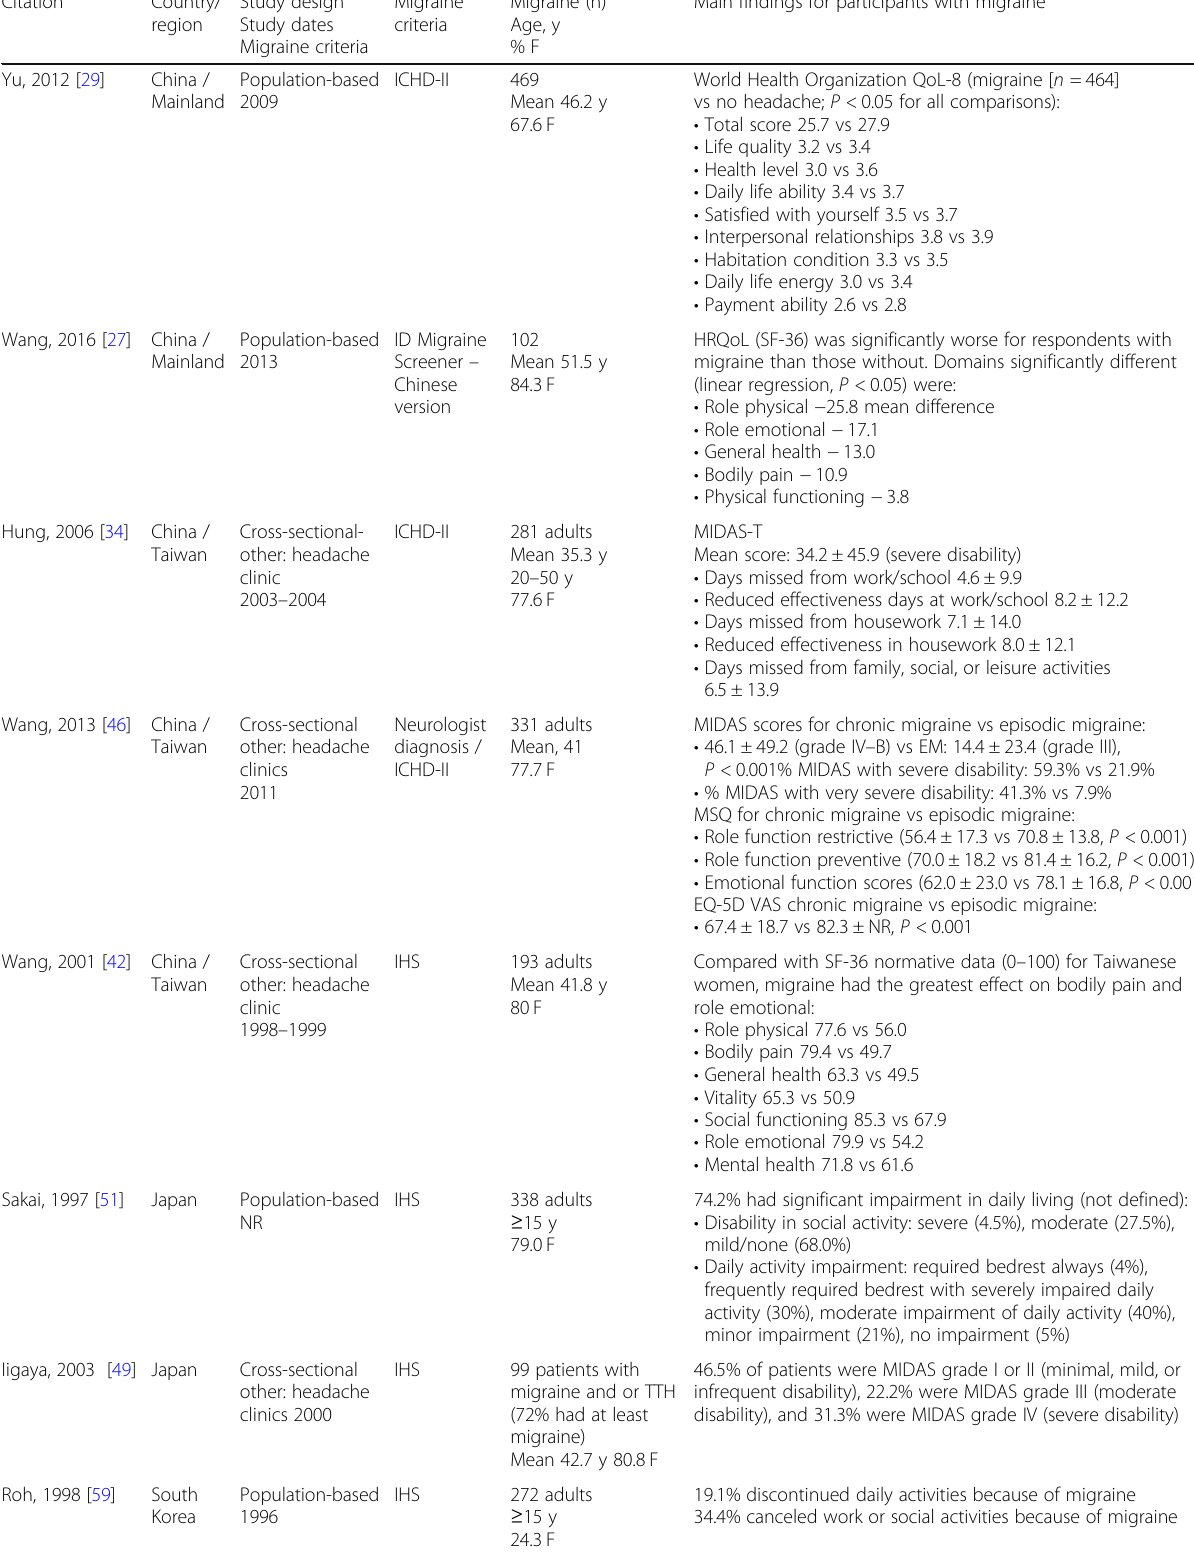
Table 1 Studies reporting humanistic burden of migraine